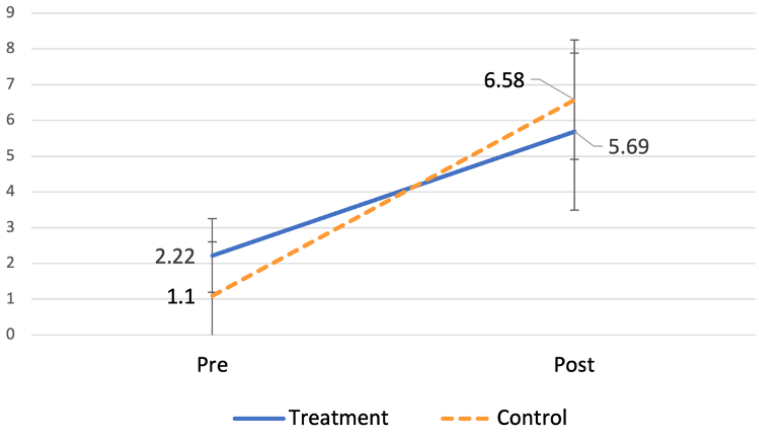
Figure 1. VIS change pre- versus post-operation.